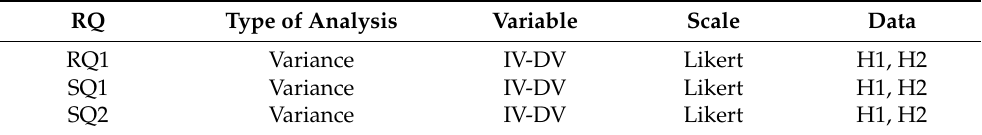
Table 2. Research question and hypotheses testing. RQ Type of Analysis Variable